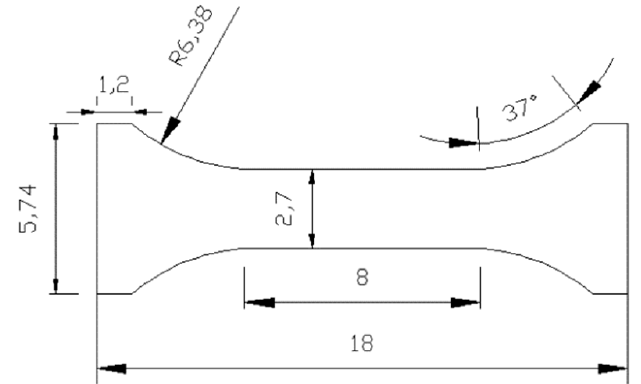
Figure 2. Geomertry dimensions of the ‘I’-shaped tensile sample.